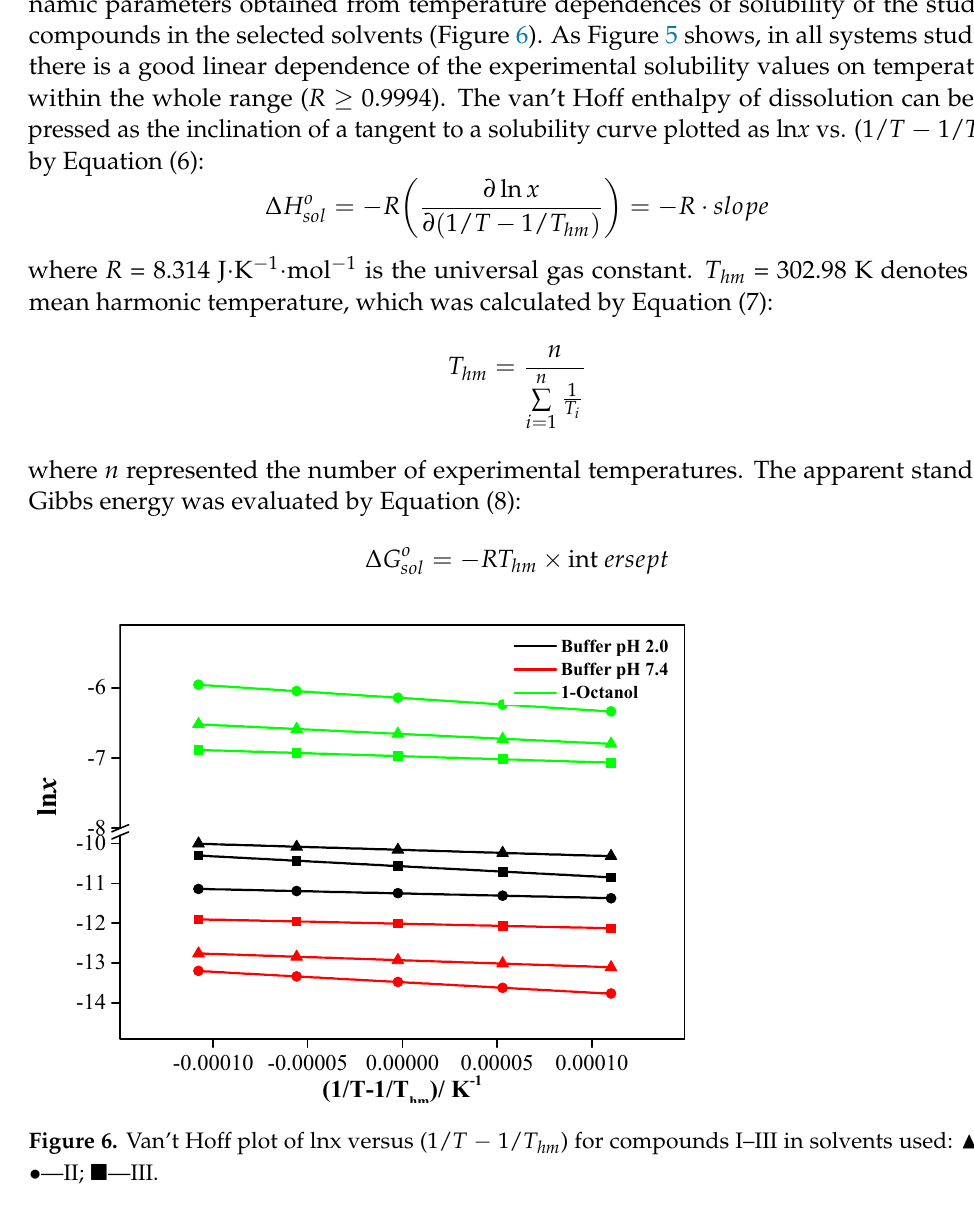
Table 4. Apparent thermodynamic solubility functions of compounds studied in buffer solutions (pH 2.0 and 7.4) and 1-octanol at T hm = 302.98 K and pressure p = 0.1 MPa. Compound